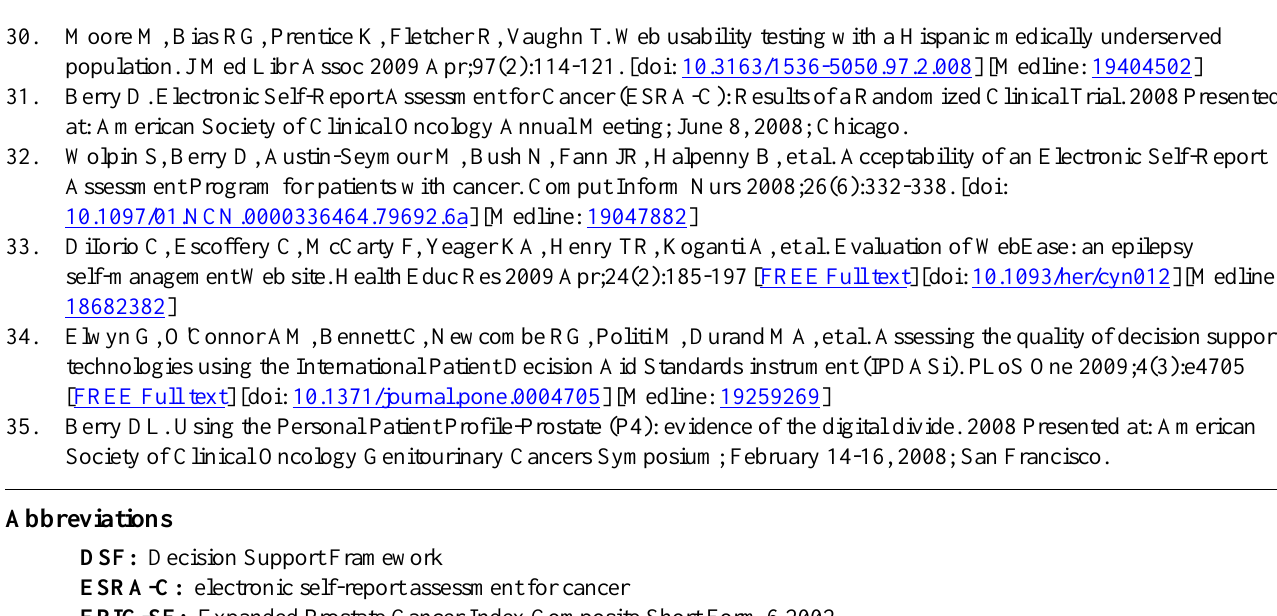
PIP: Patient Information Program P3P: Personal Patient